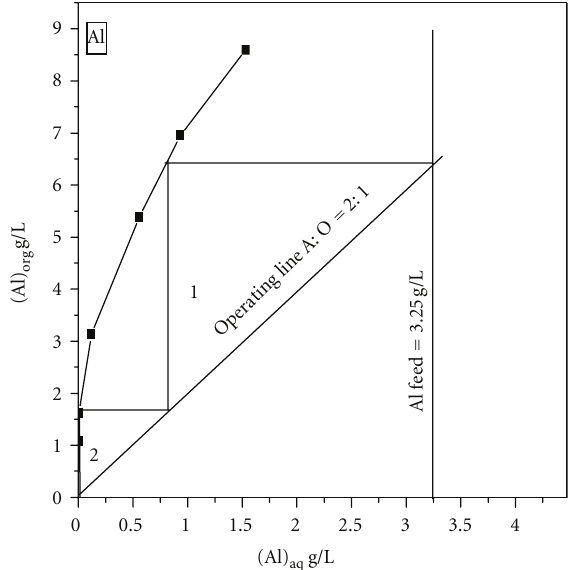
Figure 2: McCabe-Thiele plot for Al extraction. Conditions: Al = 3.25 g/L; Ni = 85 g/L; equilibrium pH, 2.23; A/O, 1/1–3 and O/A, 1/1–5.